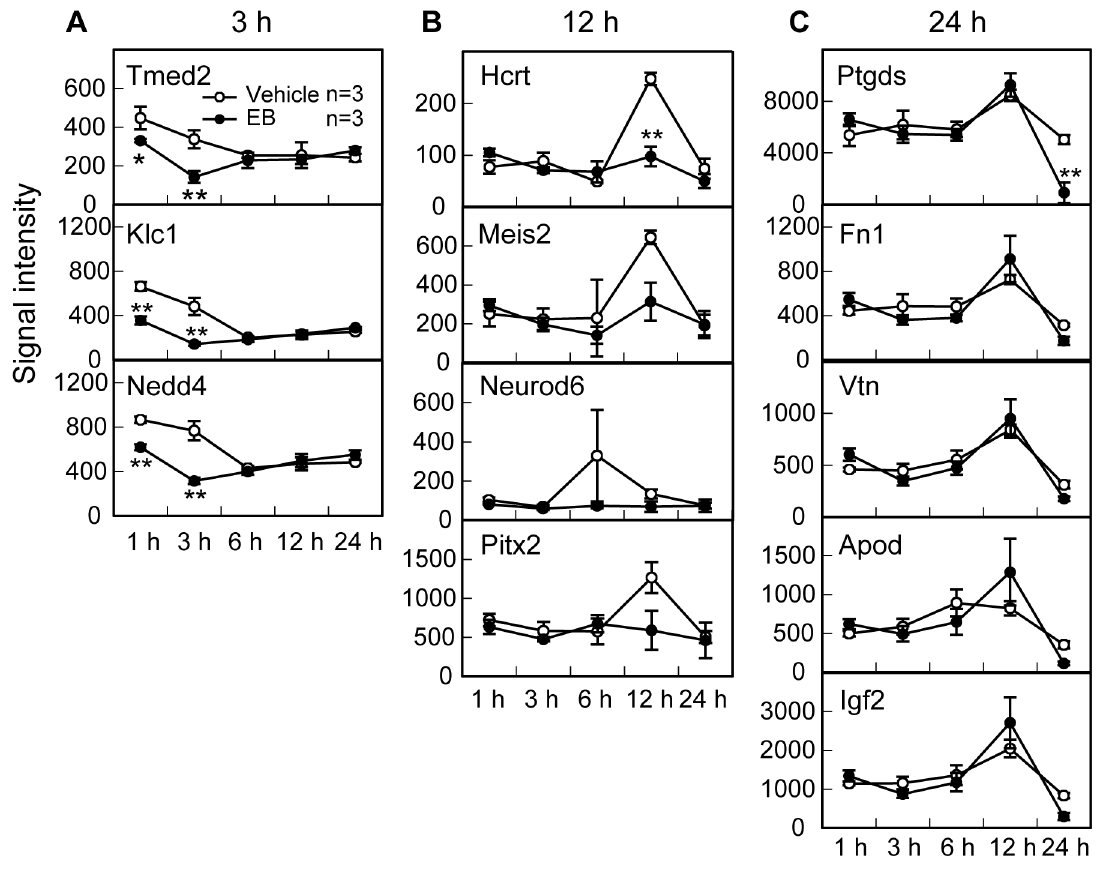
Figure 3. Changes in expressions of Tmed2 , Klc1 , Nedd4, Hcrt , Meis2 , Neurod6 , Pitx2, Ptgds , Vtn , Fn 1 , Apod , and Igf2 genes in the female mouse hypothalamus 3 h (A), 12 h (B), or 24 h (C) after the EB treatment. Values in EB-treated (solid circle) and vehicle-treated controls (open circle) are indicated as signal intensity in microarray hybridization. Values are means ±SEM. Values marked with asterisks (* or **) are significantly different from vehicle-treated controls at each time point (P < 0.05 or P < 0.01, two-way ANOVA (treatment and time as main factors) followed by the Bonferroni test). doi: